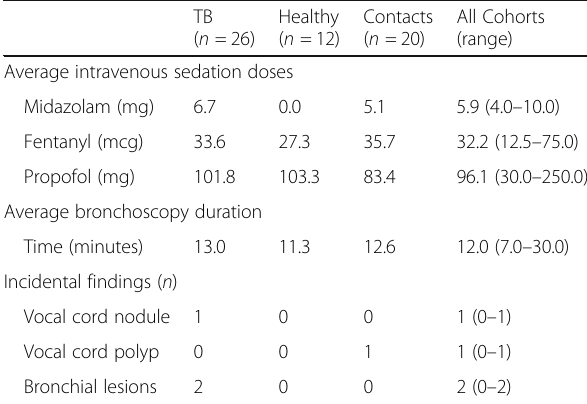
Table 2 Average intravenous sedation doses,